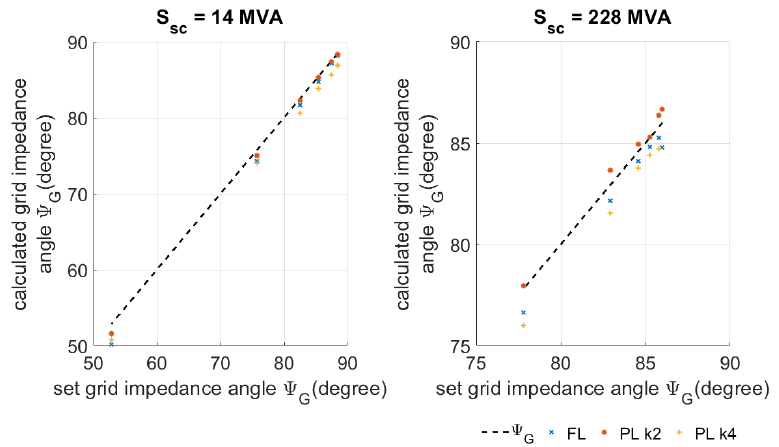
Figure 5. Calculated and measured grid impedance